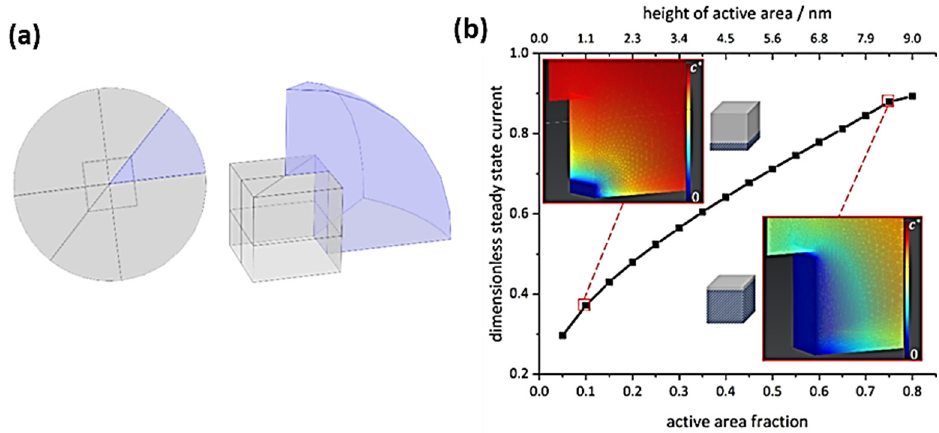
Figure 5. ( a ) Schematic representation of the model geometry (not true to scale) used for simulating the diffusional flux towards a single nanocube. Here, the magnitude of the steady state flux is equal for diffusion towards and away from an electrode, hence only diffusion profiles towards the electrode are shown. ( b ) Respective dimensionless steady-state currents for varying active areas, normalized to Equation (1) with five active cube faces and steady-state concentration gradients, including illustrations for varied partial cube activity, see SI section SI-III for details.